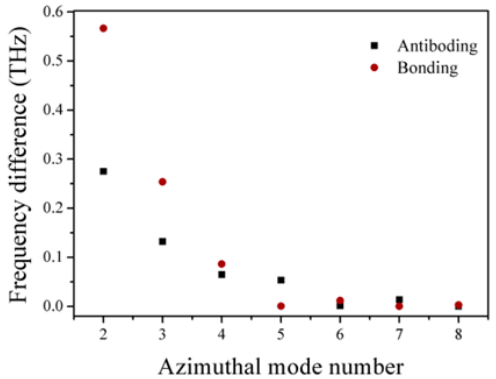
Figure 5. The frequency splitting Δ F of bonding and anti-bonding whispering-gallery (WG) modes of TM m,1 as a function of m from 2 to 8, where the distance g is 5 nm.